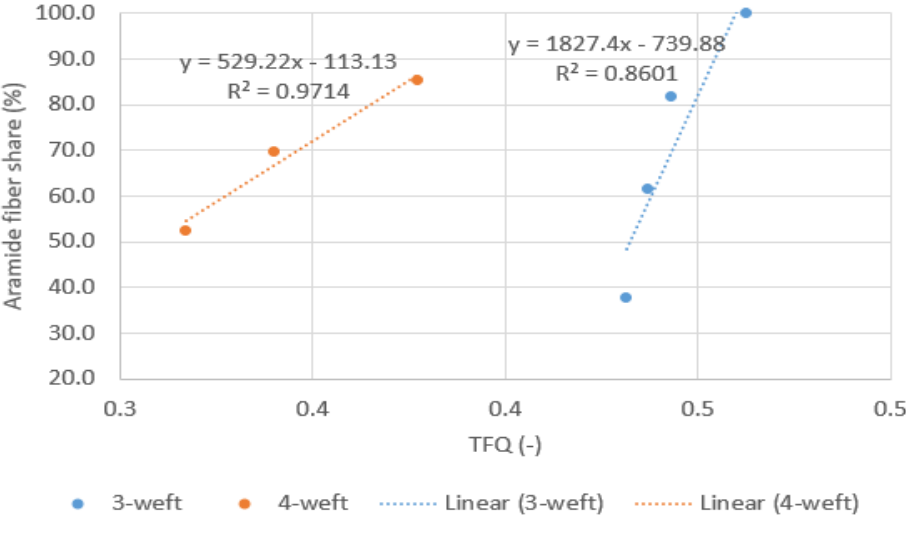
Figure 10. Correlation of aramid fiber share and TFQ with R 2 .